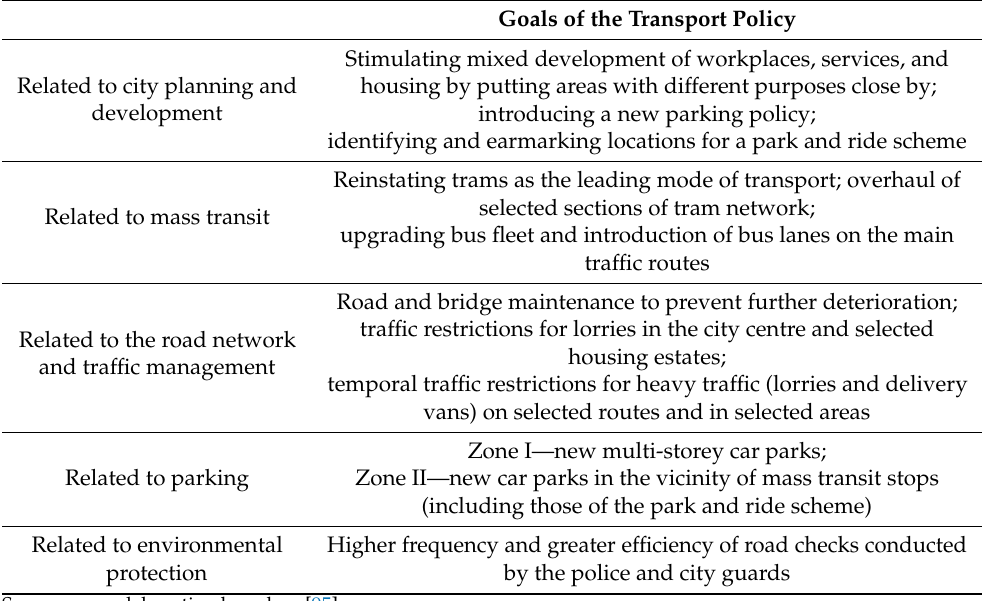
Table 4. Selected solutions applied to implement the transport policy in Ł ó